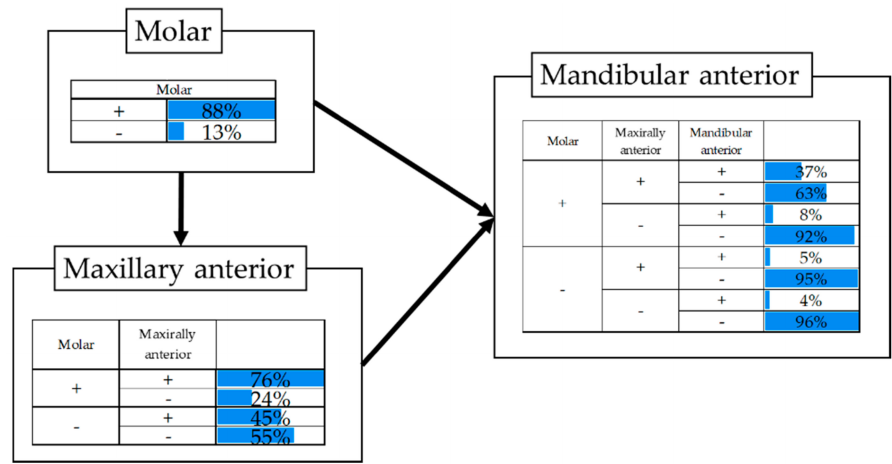
Figure 5. Bayesian network analysis of the conditional prevalence of dental caries.